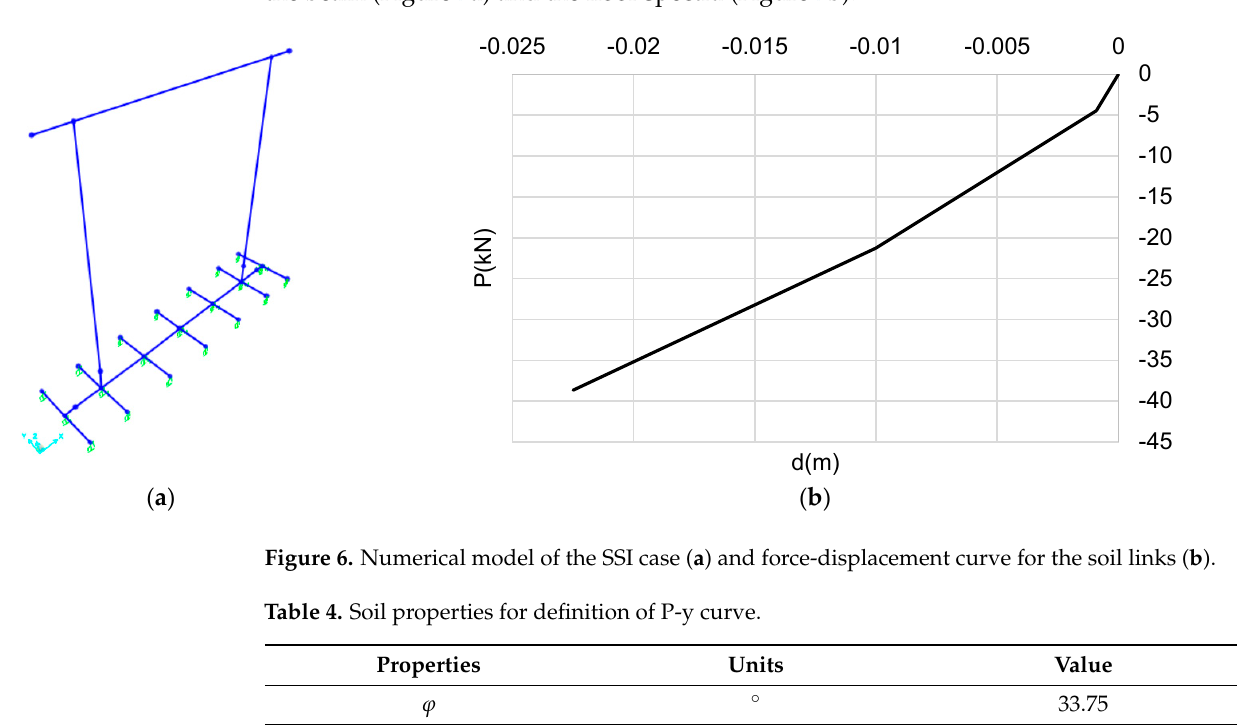
( b ) Figure 5. Fixed-base results for sine sweep excitation:( a ) displacement of the top beam and ( b ) floor spectra.